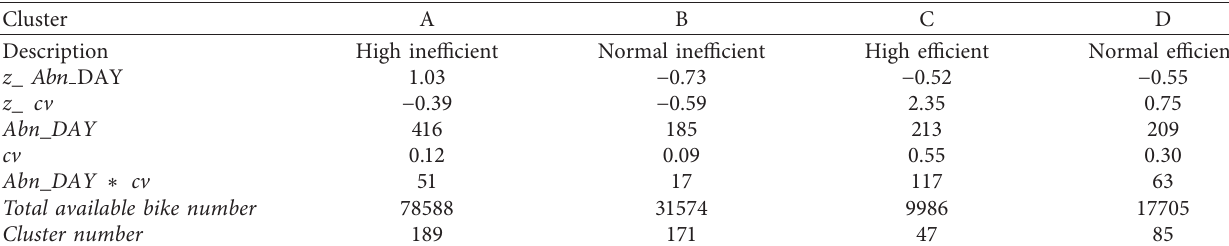
Figure 5: The accuracy of the five classification algorithms. Table 2: The description of four